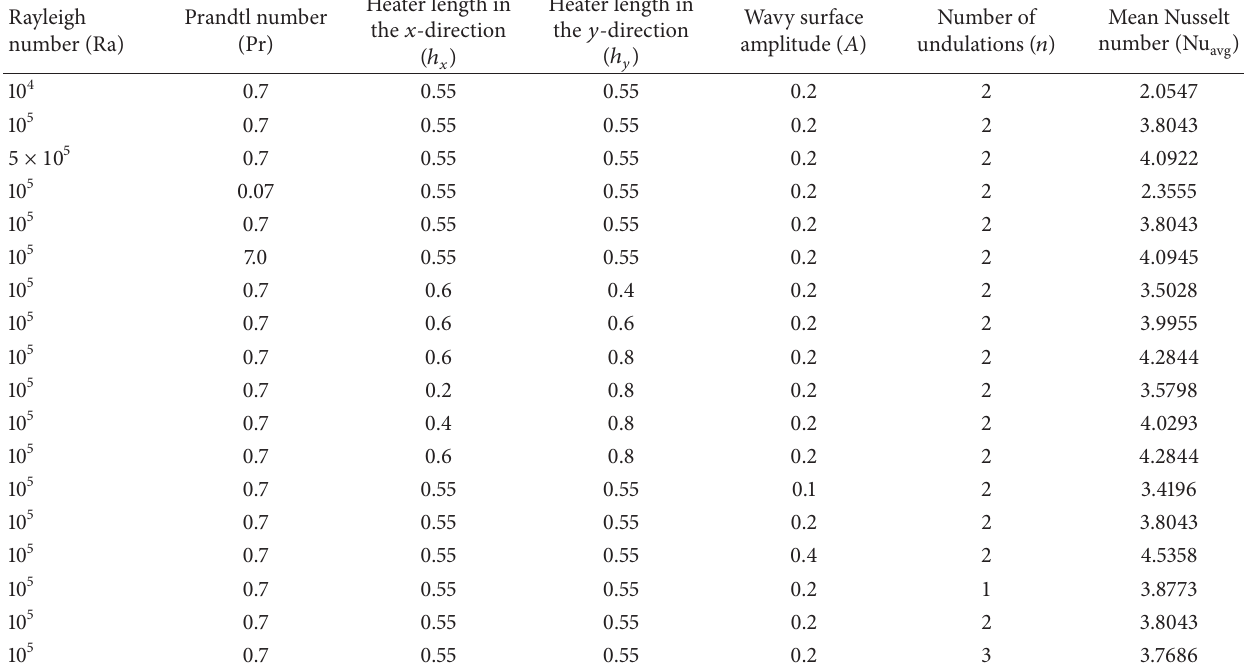
Table 2: Mean Nusselt number computed along the cold wavy surface for different